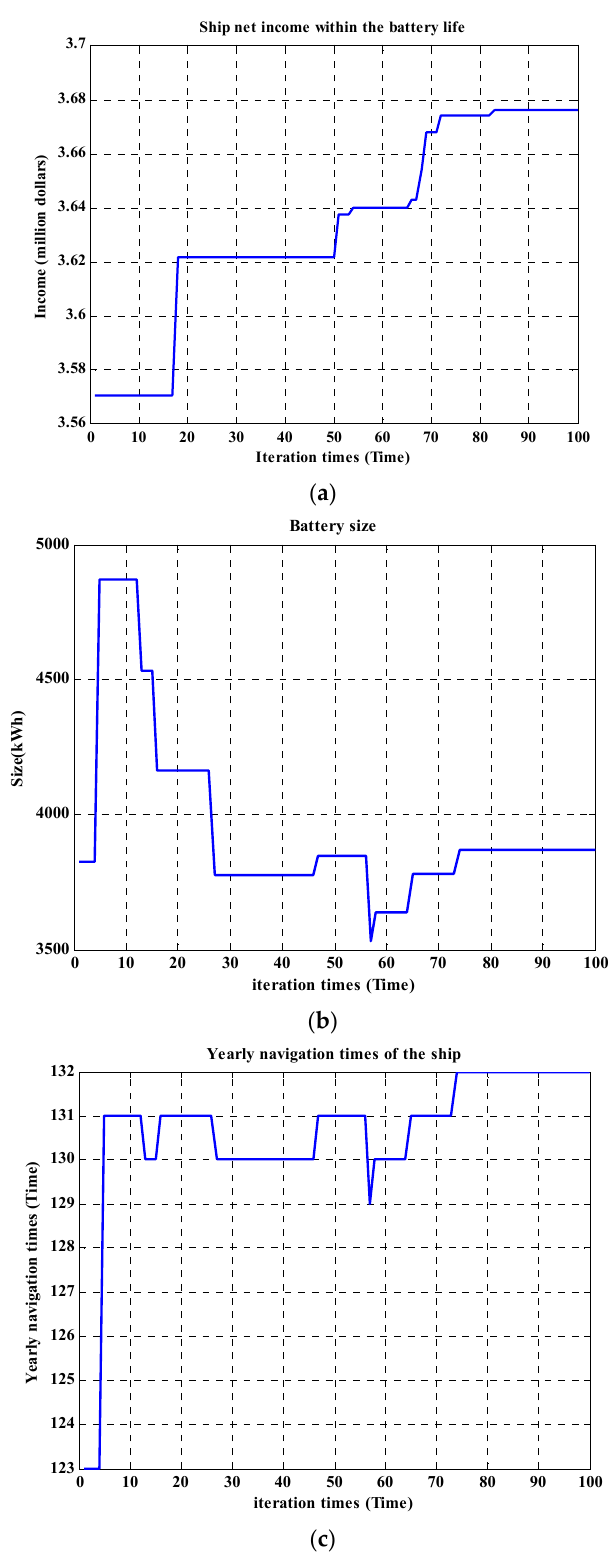
Figure 6. Simulation results of scenario 1 in case 1. ( a ) Variation of ship net income within the battery life over the optimization procedure ( b ) Battery capacity variation over the optimization procedure ( c ) Variation of yearly navigations over the optimization procedure